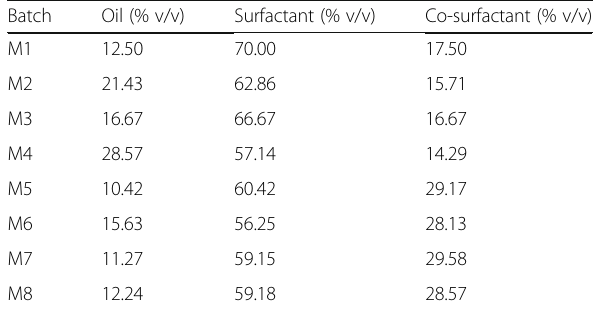
Table 1 Composition of gliclazide SMEDDS batches (M1 to M8) Batch